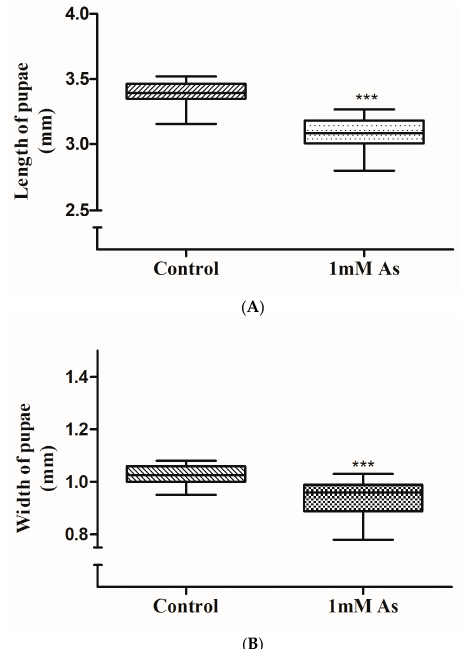
Figure 4. ( A ) The length of pupae that developed in 1 mM arsenite media and control media were measured and are represented. A decrease in the length (mm) of treated pupae compared to the control is apparent from the graph. The statistical significance ( p < 0.05) was analyzed by the Wil- coxon signed rank test with *** p < 0.0001 and 95 per cent confidence interval. ( B ) The width of pupae that developed in 1 mM arsenite media and control media were measured and are represented. A decrease in the width (mm) of treated pupae compared to the control is apparent from the graph. The statistical significance ( p < 0.05) was analyzed by the Wilcoxon signed rank test with *** p < 0.0001 and 95 per cent confidence interval. The maximum and minimum width of arsenic-treated pupae were measured as 1.03 mm and 0.78 mm, respectively. The box plot (Figure 4B) represented the measurement of the width of pupae which were developed in the arsenic and control media. The mean length of the control and treated pupae was 3.33 mm and 3.08 mm, respectively. While the mean width measured for the control and treated pupae was 1.02 mm and 0.93 mm. A minimal average relative decrease in the length and width of pupae developed in arse- nic and control media were found. The relative decrease was 0.25 mm and 0.05 mm in length and width, respectively, and was statistically significant. Following measuring the length and width of the pupae, they were restored into their respective bottles to monitor their further development. The adult fly did not eclose from 1 mM arsenic media but flies eclosed from the control media bottle.